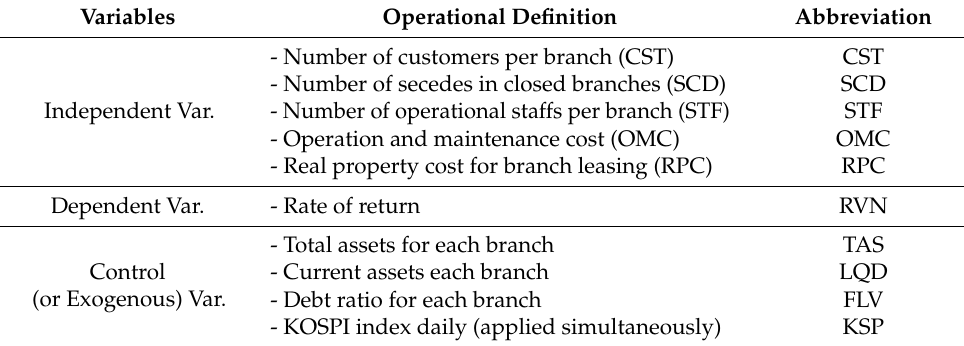
Table 6. Operational